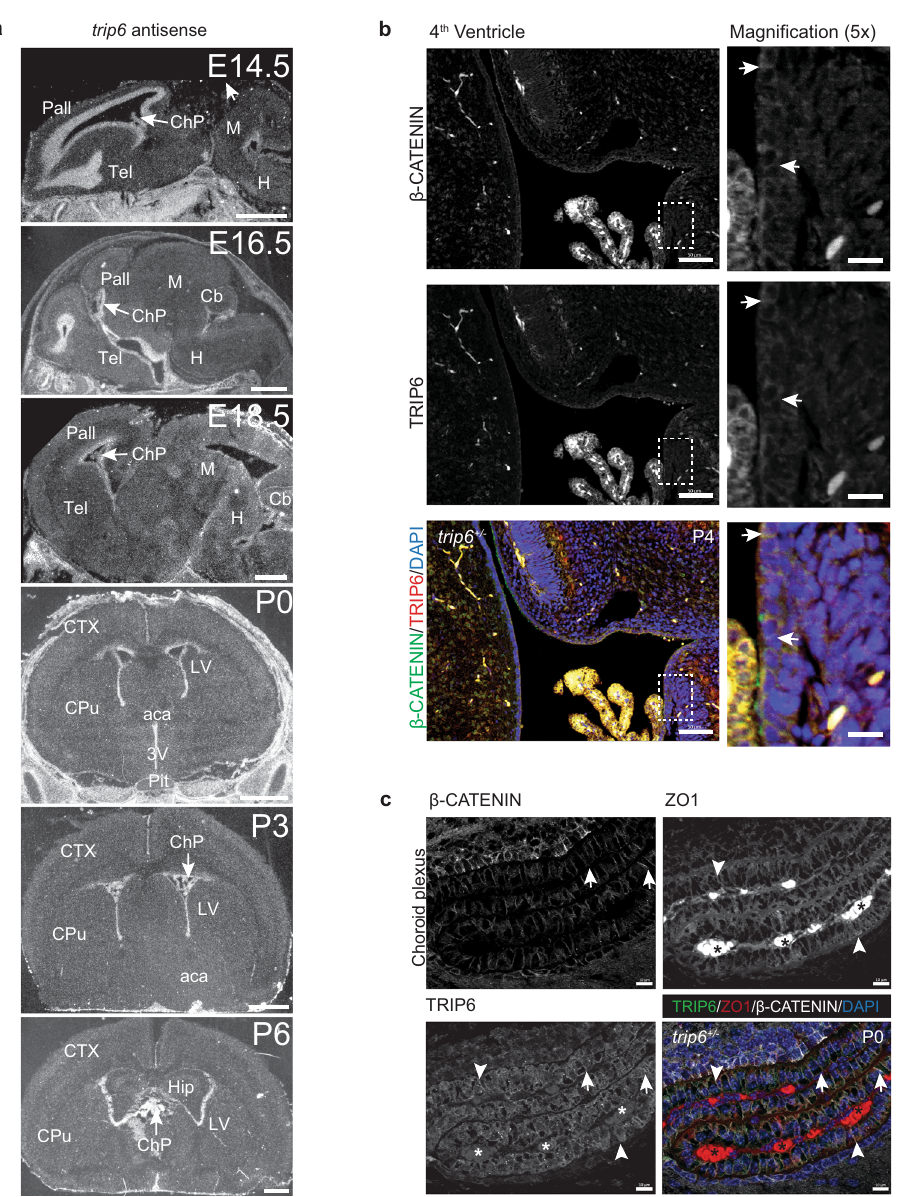
Fig. 1 Expression of trip6 in embryonic and postnatal brain. a mRNA expression in trip6 + / + mouse brain sections by in situ hybridization (ISH) depicting embryo sagittal sections (E14.5 – E18.5) and postnatal coronal sections (P0 – P6). Pall pallium, M midbrain, Tel telencephalic vesicle, H hindbrain, ChP choroid plexus, Cb cerebellum, CTX cerebral cortex, CPu Caudate Putamen, aca anterior commissure, Pit pituitary, LV lateral ventricle, 3V third ventricle, Hip hippocampal formation. Choroid plexus locations within the lumen of the ventricles are indicated by arrows. Control sense ISH is shown in Supplementary Fig. 1a, b. Immuno fl uorescence labeling of TRIP6 in ependymal cells lining the 4th ventricle ( b ) and choroid plexus epithelium ( c ) demonstrates its co-localization with β -catenin (arrow) and ZO1 (arrowhead). Nuclei were stained with DAPI. The marked areas are magni fi ed in the insets. Ages are indicated in the fi gure. For number of mice analyzed, please see “ Methods ” section. Asterisk (*) indicates the auto fl uorescence of the choroid plexus vasculature. Scale bars: 1 mm ( a ), 50 μ m and 250 μ m ( b and magni fi ed images, respectively), 10 μ m ( c cells — the ependymal cells — comprising the ependyma. The Examples of trip6 − / − ependymal layers are shown in Fig. 3c ependymal layer is interspersed with basal cells some of which are indicating different degrees of poor differentiation. stem cells (Fig. 3a, arrowheads), providing a neurogenic niche 28 . Immuno fl uorescence labeling, using anti-S100 β , con fi rmed the Analysis of trip6 − / − brain sections (Fig. 3a) revealed a poorly defective differentiation of ependymal cells in trip6 − / − brain differentiated epithelial layer comprising atrophic ependymal cells (Fig. 4 and Supplementary Figs. 3 and 4a; ependymal cells that exhibit “ endothelial ” aspects (i.e., fl attened cell morphology indicated by arrows). Note that S100 β is expressed not exclusively and reduced cytoplasm, as indicated by high nuclear/cytoplasmic in ependymal cells, but also in some glia cells (Fig. 4 and ratio) as well as aberrant ciliation demonstrated by defects in cilia Supplementary Fig. 3, arrowheads; Supplementary Fig. 4a, stars) number and length (see below). Furthermore, only few basal cells in agreement with previous reports 29 . In addition to this defective morphology, elimination of S100 β -expressing cells from the VZ were observed (Fig. 3a), suggestive of defective cell renewal, or was occasionally observed (Supplementary Figs. 3 and 4). re fl ecting an early cause of poor ependymal differentiation.